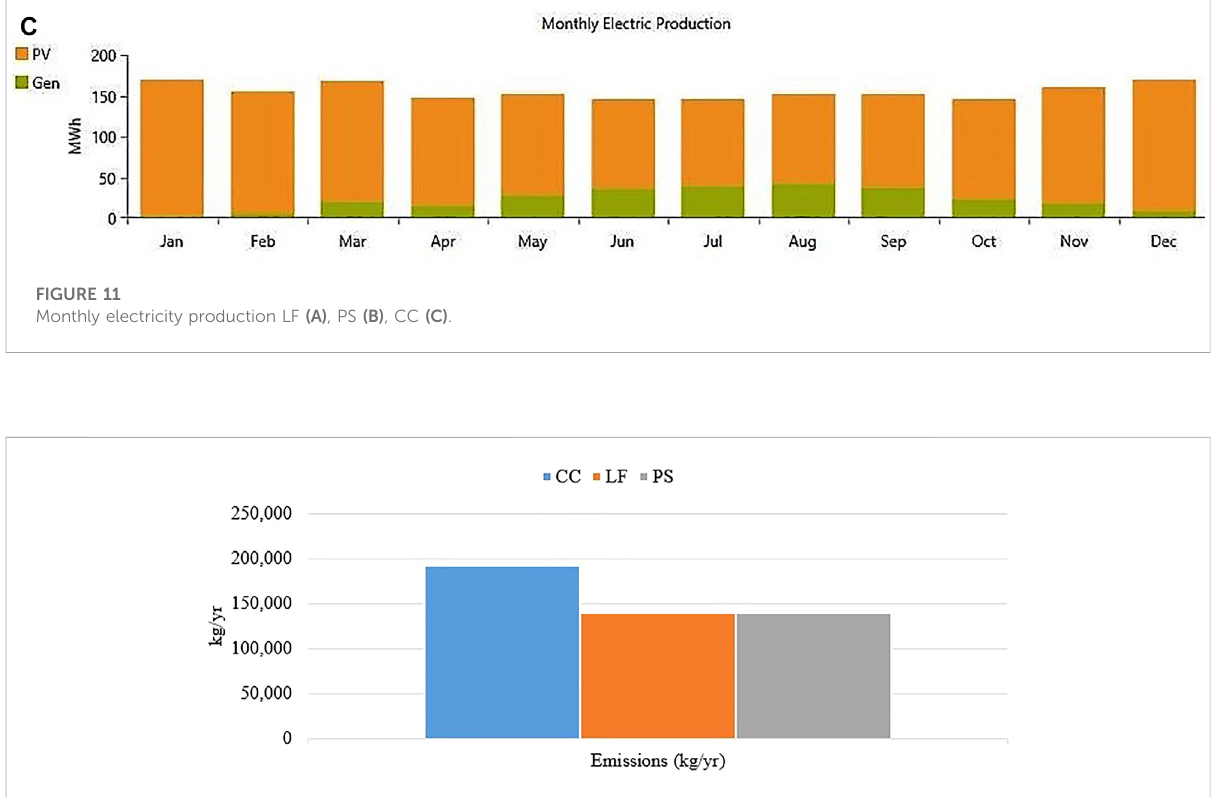
FIGURE 12 Overall emissions of the proposed system under different